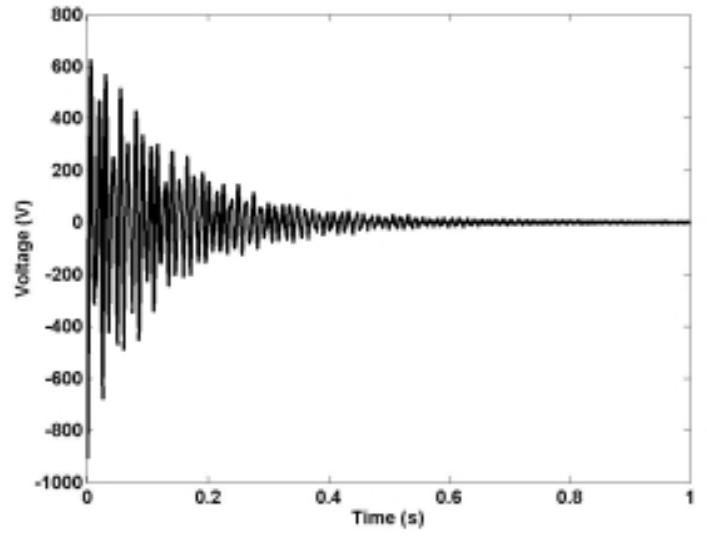
Fig. 10. Feedback control voltage applied by the piezoelectric actuator when the EMC strategy is